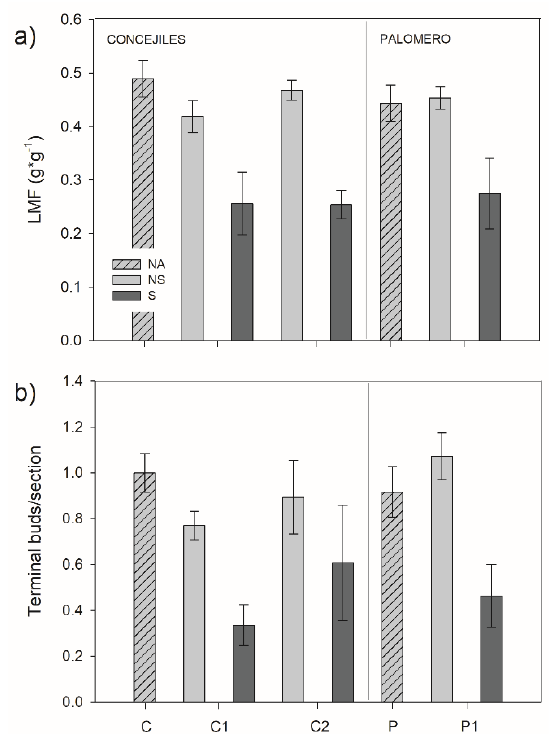
Figure 5. Panel ( a ) Leaf mass fraction (g × g − 1 ) measured for each pine stand and disease degree. The striped dark gray bars show the values for the NA-trees; the smooth light gray bars show the values for the NS-trees; the smooth dark gray bars show the values for the S-trees. Data are mean ± SE of n = 6 pines per stand and disease degree. Panel ( b ) Relation between the number of terminal buds by branch section (mm − 2 ), measured for each pine stand and disease degree. The striped dark gray bars show the values for the NA-trees; the smooth light gray bars show the values for the NS-trees; the smooth dark gray bars show the values for the S-trees. Data are mean ± SE of n = 6 pines per stand and disease degree. Table 3. Summary statistics of Linear Model for disease degree (NS and S) at di ff erent pine stands (C1, C2, and P1). Significant di ff erences at p < 0.05 are shown in bold and the marginal significant di ff erences in italics. Acronym “nd” represents no di ff erences (i.e., p > 0.05) in the post hoc test between stands, “S” refers to stand factor and “D” refers to disease degree